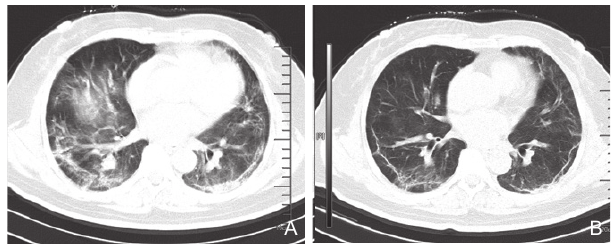
Figure 2 CT pulmonary images of severe COVID-19 pre- and post- treatment. (A) Pre-treatment; (B)